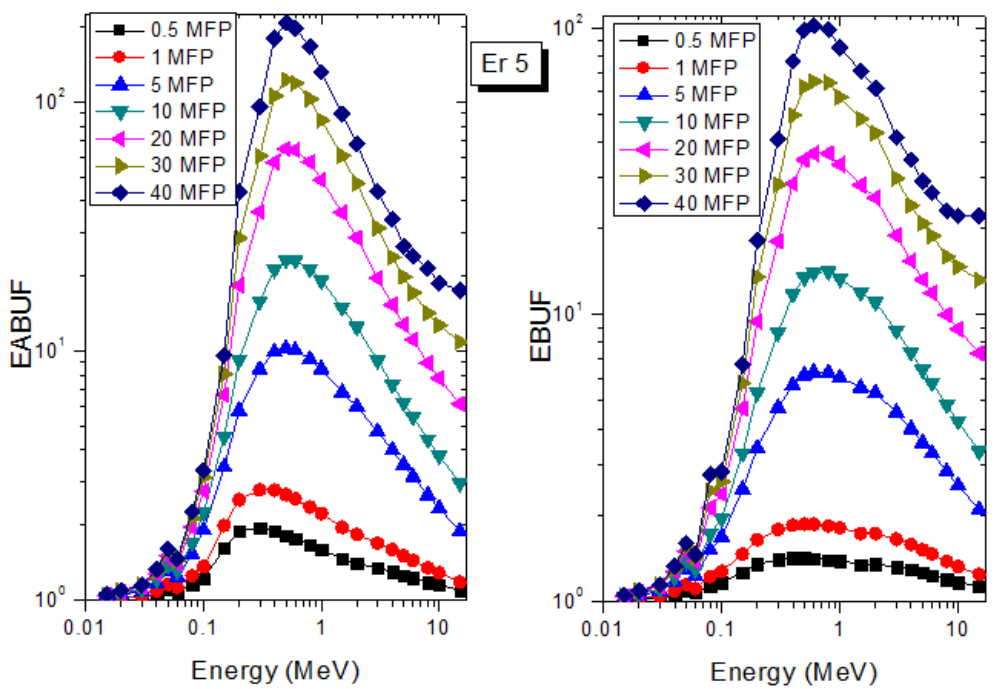
Figure 5. EABUF and EBUF variation with gamma-ray photon energy for Er 5.